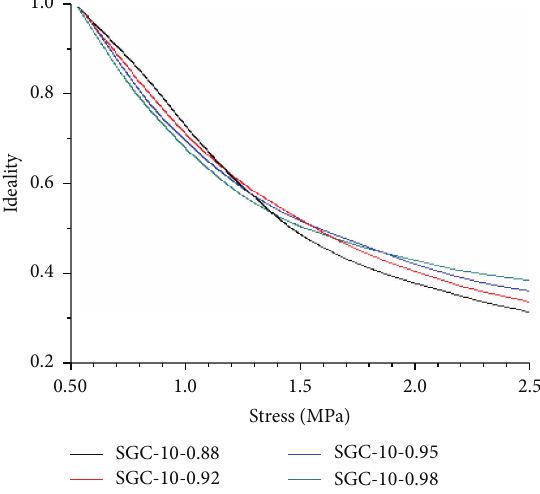
Figure 14: Ideality of the